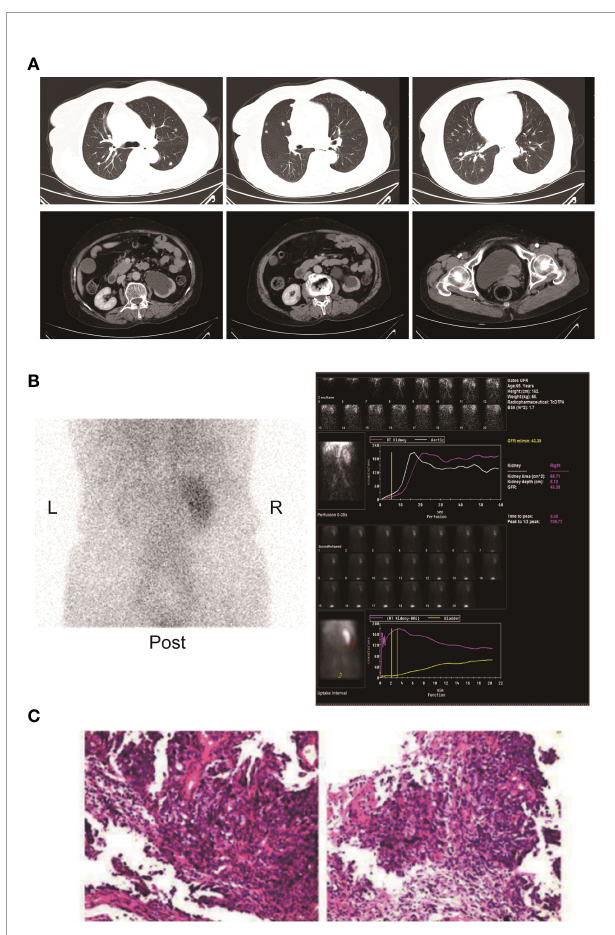
FIGURE 1 | (A) Enhanced CT of the chest and pelvis showed multiple round nodules in both lungs with clear boundaries. A dense mass of soft tissue is seen at the entrance of the ureter on the left side of the bladder. The size is about 25mm*22mm. (B) Renal dynamic imaging and glomerular fi ltration. 1. Renal blood perfusion image: After intravenous "projectile" injection of imaging agent 99m-Tc-DTPA, renal blood perfusion imaging was performed. After imaging of the abdominal aorta, the right kidney was immediately imaged, and the position, shape and the size is roughly normal, and the radioactivity distribution is roughly even; the left kidney is not seen. 2. Renal function shows: After renal blood fl ow perfusion, the left kidney is not visible; the shadow of the right kidney gradually increases, and the imaging of right kidney reaches a peak at 3.35 minutes. After that, the shadow of the renal cortex diminishes, the shadow of the renal medulla increases, and the renal excretion process. There was no abnormal re fl ex concentration in the right renal pelvis; after 5 hours of delay, the right kidney was lightened, there was no radioactive concentration in the right renal pelvis and ureter, and the left kidney was slightly developed. 3. Renal functional curve shows: the curve of the right kidney is roughly normal; the peak time of the right kidney is 3.35min; the GFR of the right kidney is: 43.39ml/min. (C) Pathological results of HE staining on cystoscopy